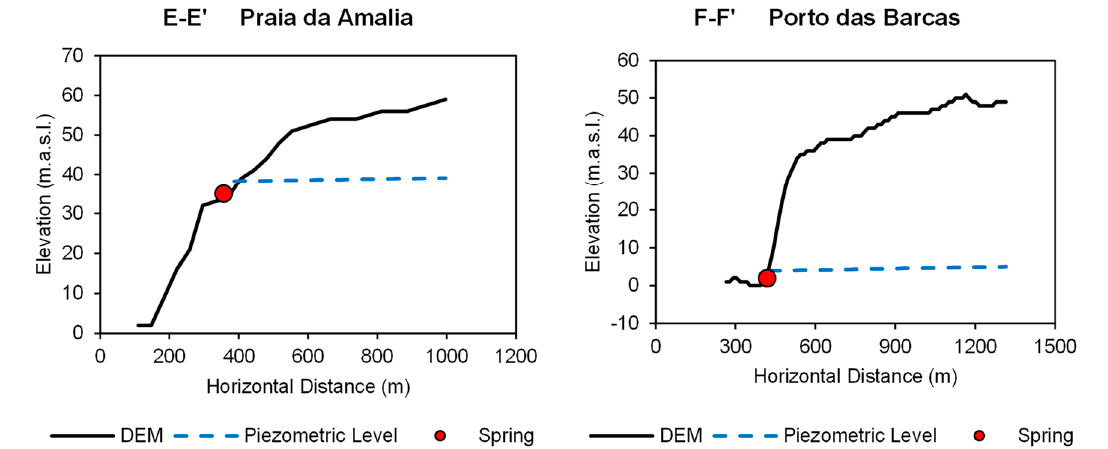
Figure 9. Coastal springs profiles based on the comparison of the Digital Elevation Model (DEM) and the average piezometric surface of the hydrological